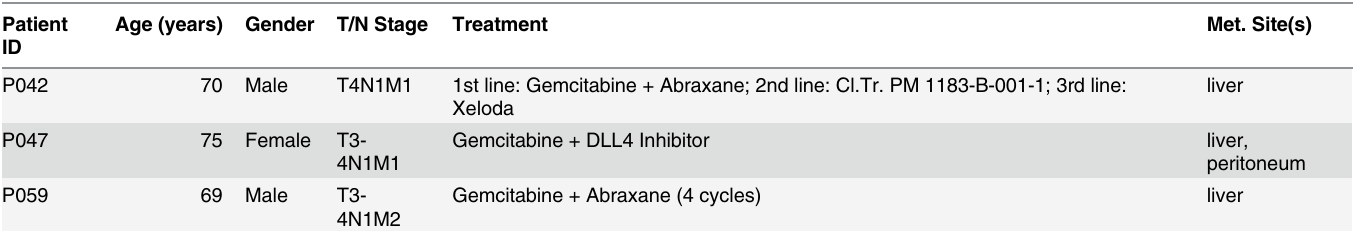
Table 5. Patient information. Patient